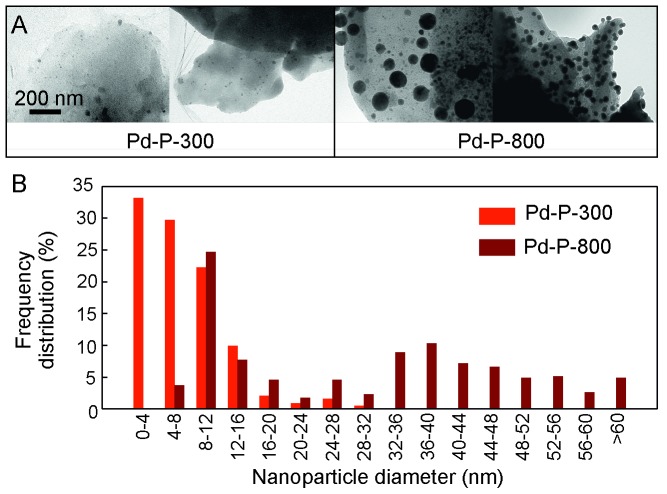
(A) TEM showing PdNPs in Pd-P-300 and Pd-P-800.(B) Distribution of PdNP sizes in the plant catalysts.